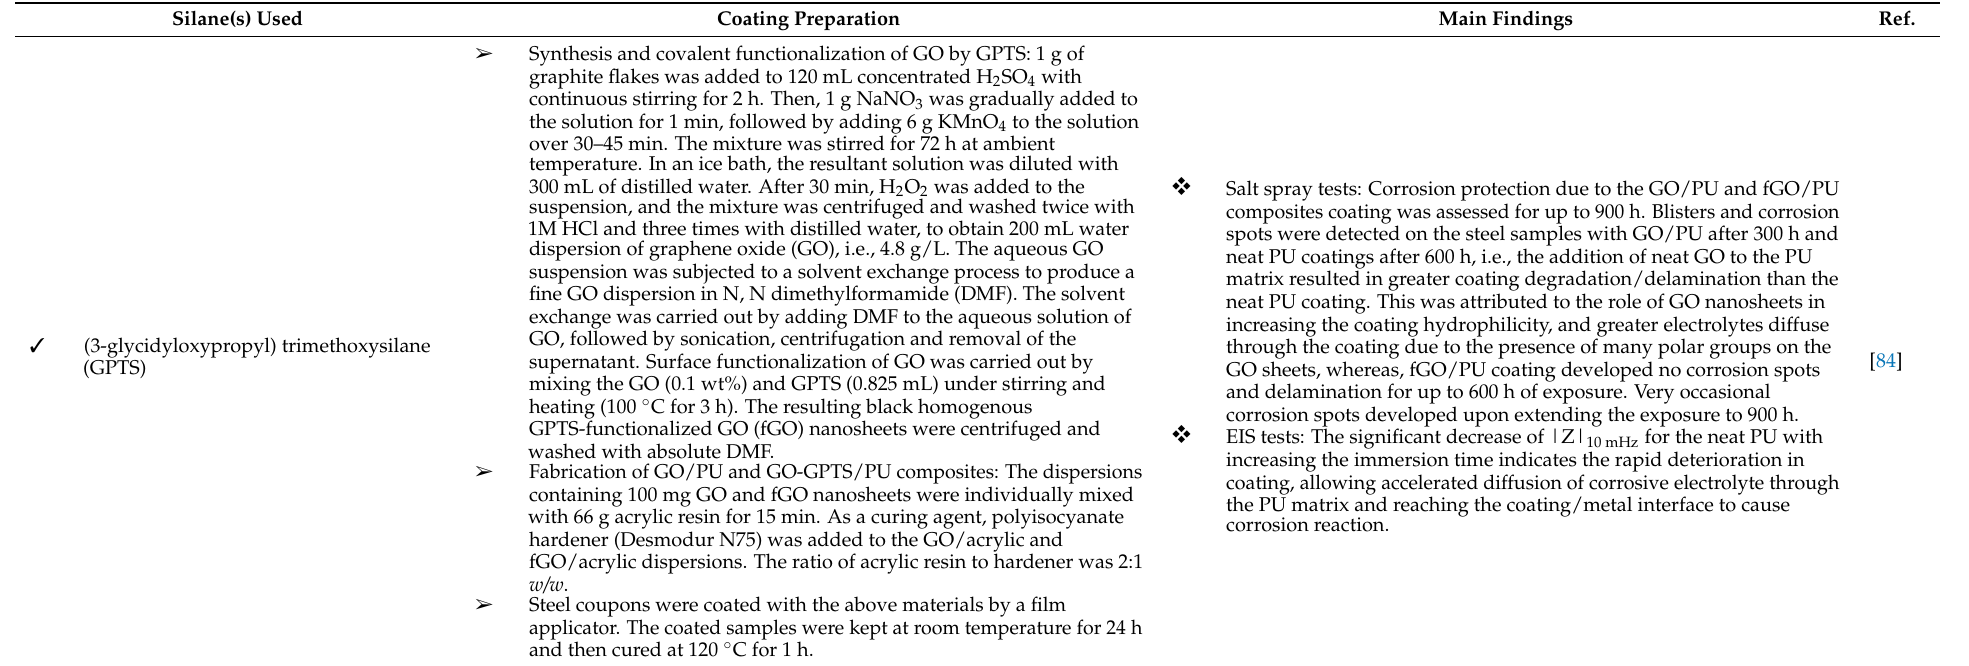
Table 1. Cont . Coating Preparation Main Findings